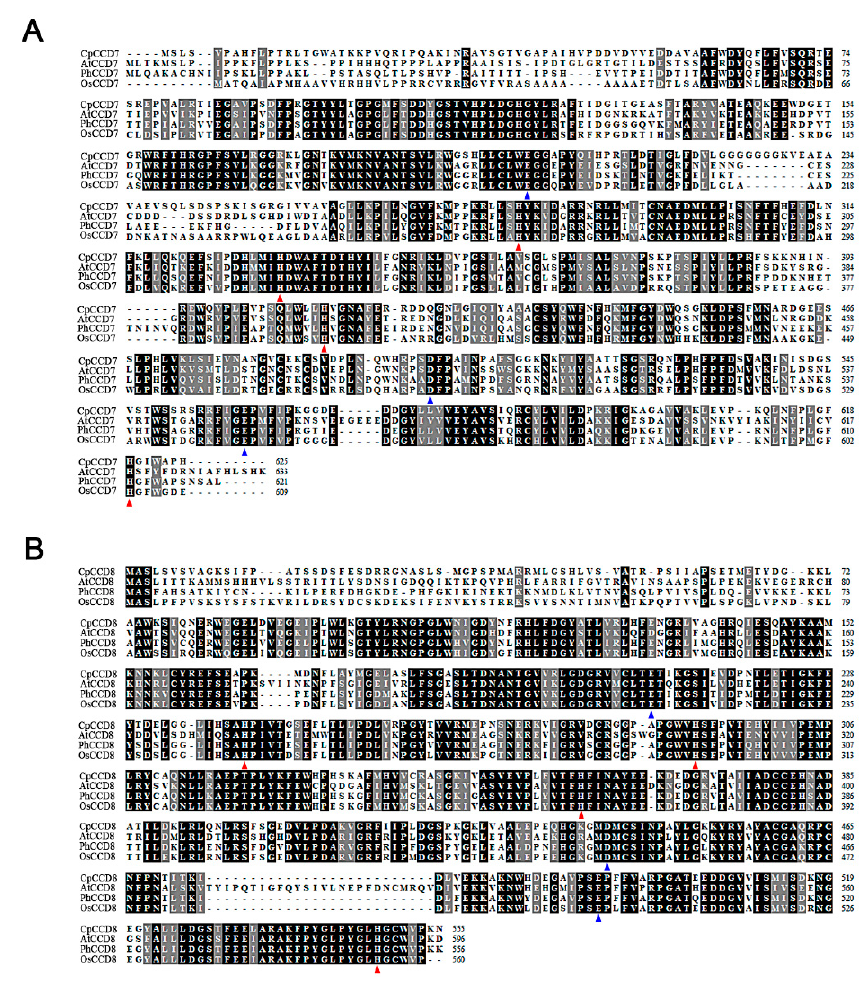
Figure 1. Multiple amino acid sequence alignment of CCD7 and CCD8. ( A , B ) Alignments of CCD7 ( A ) and CCD8 ( B ) amino acid sequences of different plant species. Cp, Chimonanthus praecox ; At,